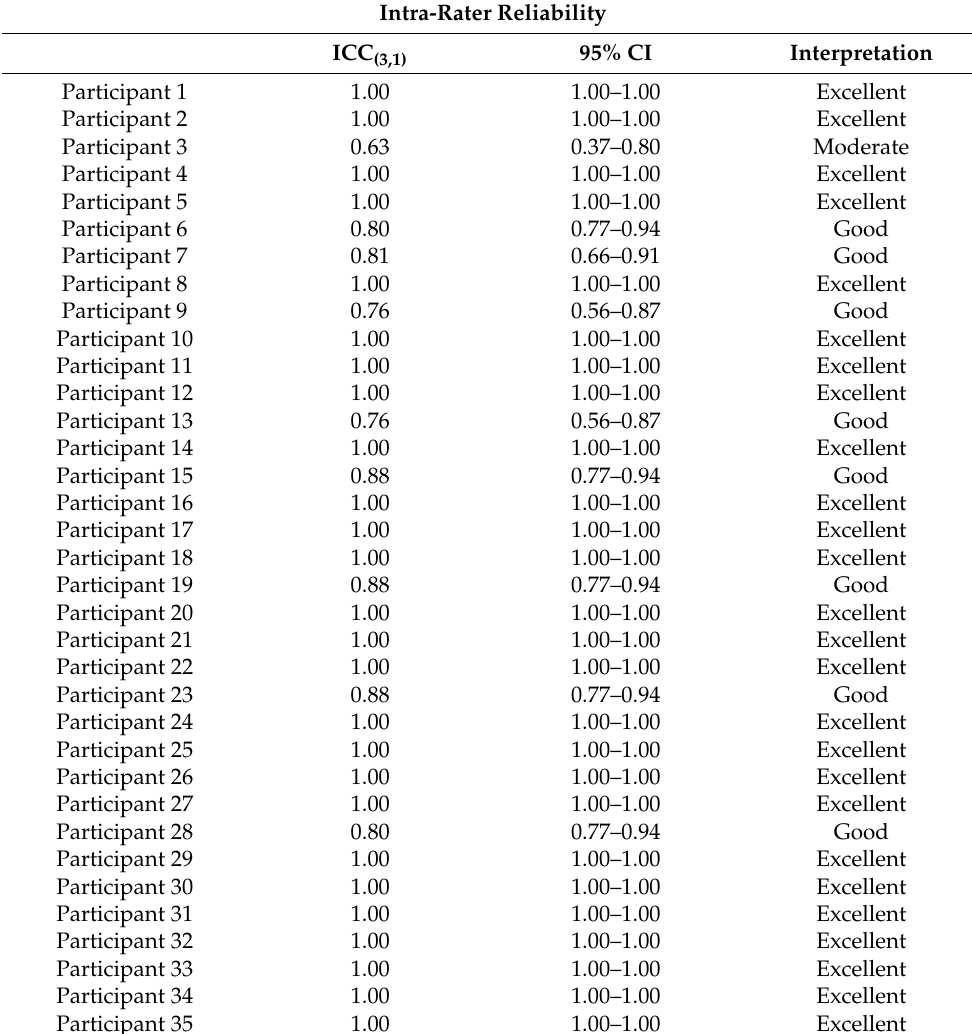
Table 4. Intra-rater reliability between each rating session. ICC = Intraclass correlation coefficients, CI = Confidence